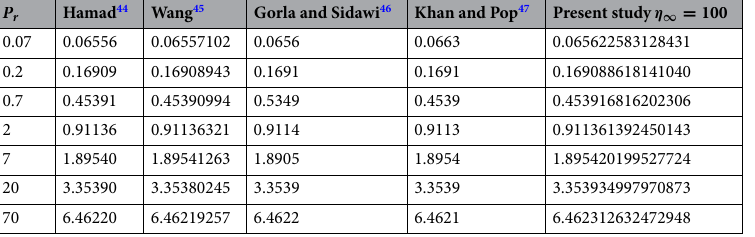
A 4 0 , Q 1 , M e = S = A 2 = A 5 = =